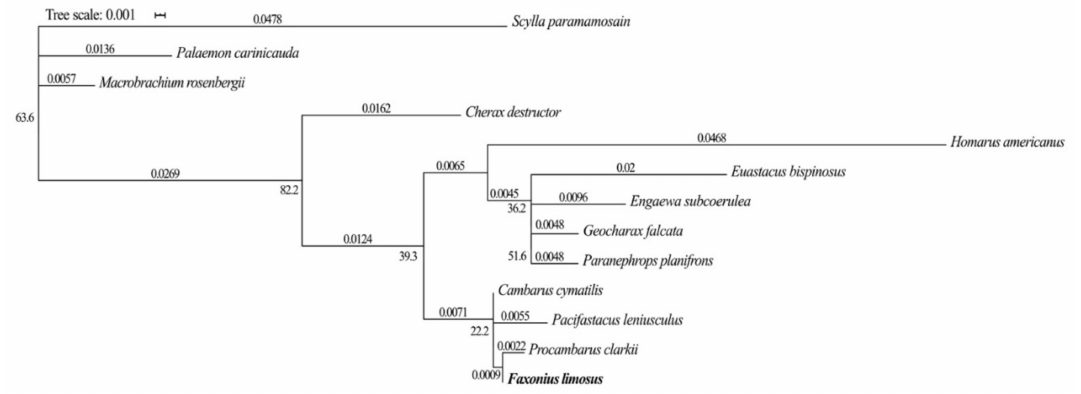
Figure 2. The phylogenetic tree for the gapdh gene of F. limosus . Abbreviations: figures above the branches and next to the nodes denote their length and bootstrap value,